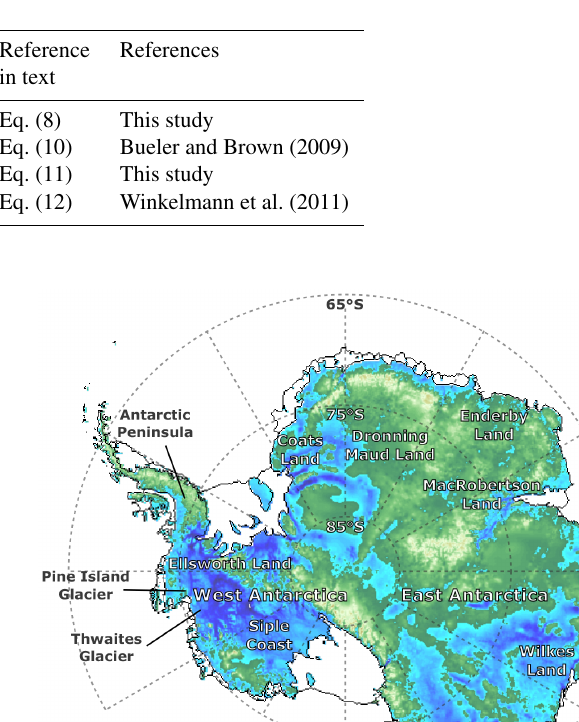
Table 2. Summary of the hybrid schemes implemented in this study.